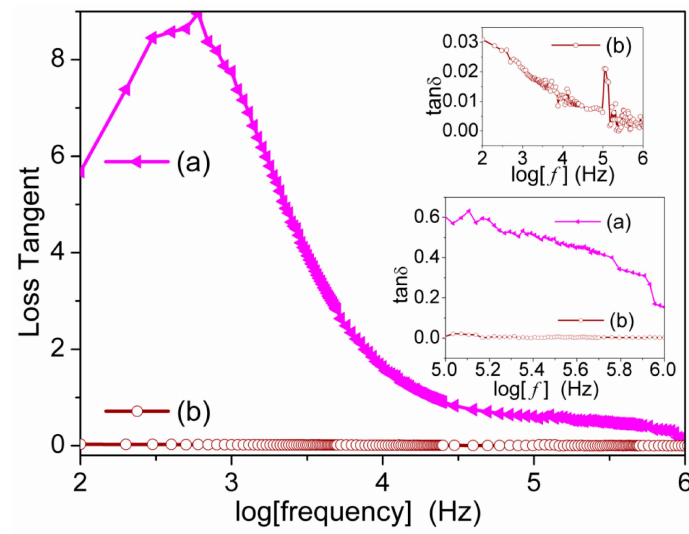
Figure 14. Frequency dependence dielectric loss tangent (tan δ ) of ( a ) sintered pellet at 1050 ˝ C (pink (S1050)) and ( b ) composite film (brown (S1050/PDMS)). The inset represents the precise observation at